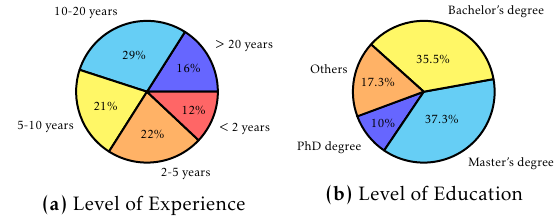
Figure 2. Demographics of experts